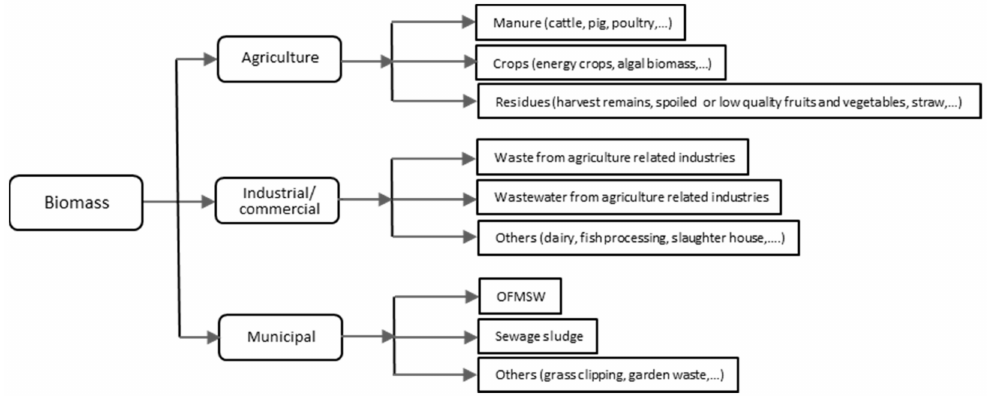
Figure 2. Classification of feedstocks potentially available for AD. Adapted from